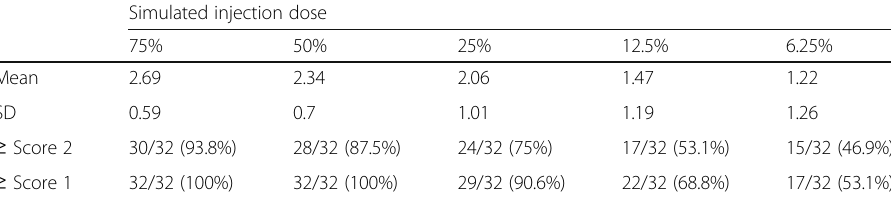
Table 1 Image quality score for dose-reduced dbPET images of 32